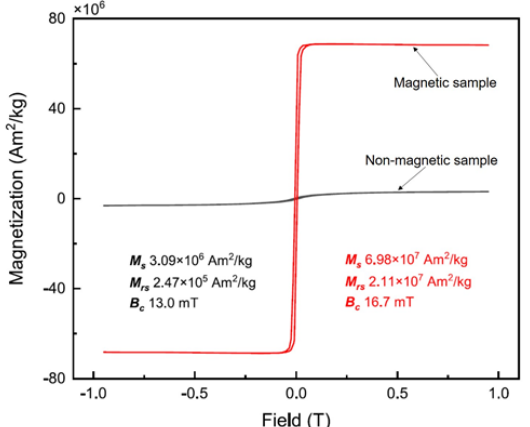
Figure 2. Magnetic hysteresis loops of (non-) magnetic fractions in the mine waste sample.